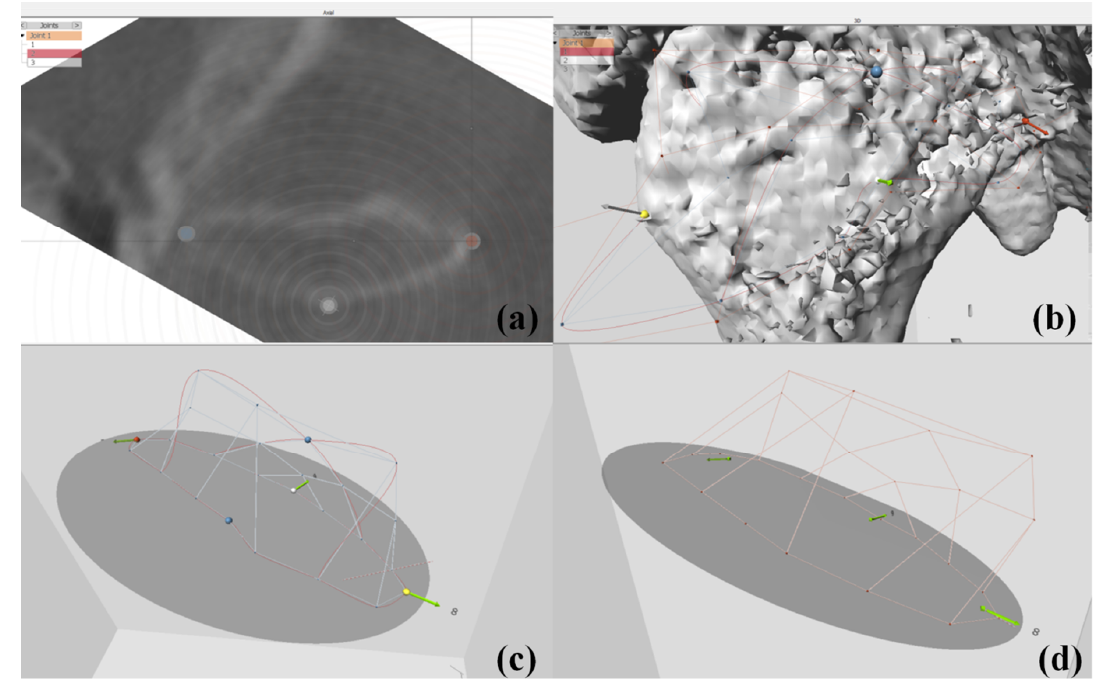
Figure 6. Volumetric measurement of the condyle-fossa unit on Checkpoint: ( a ) axial view of three